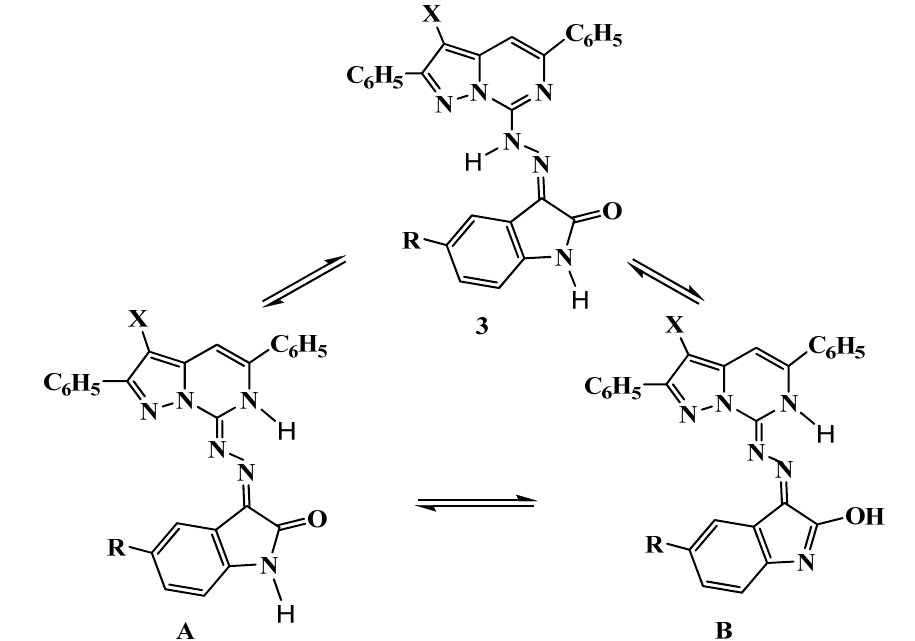
Figure 1. Isomerisation of ( E )-3-{2-(2,5-diphenylpyrazolo[1,5- c ]pyrimidin-7-yl)hydrazono} indolin-2-ones ( E )- 3